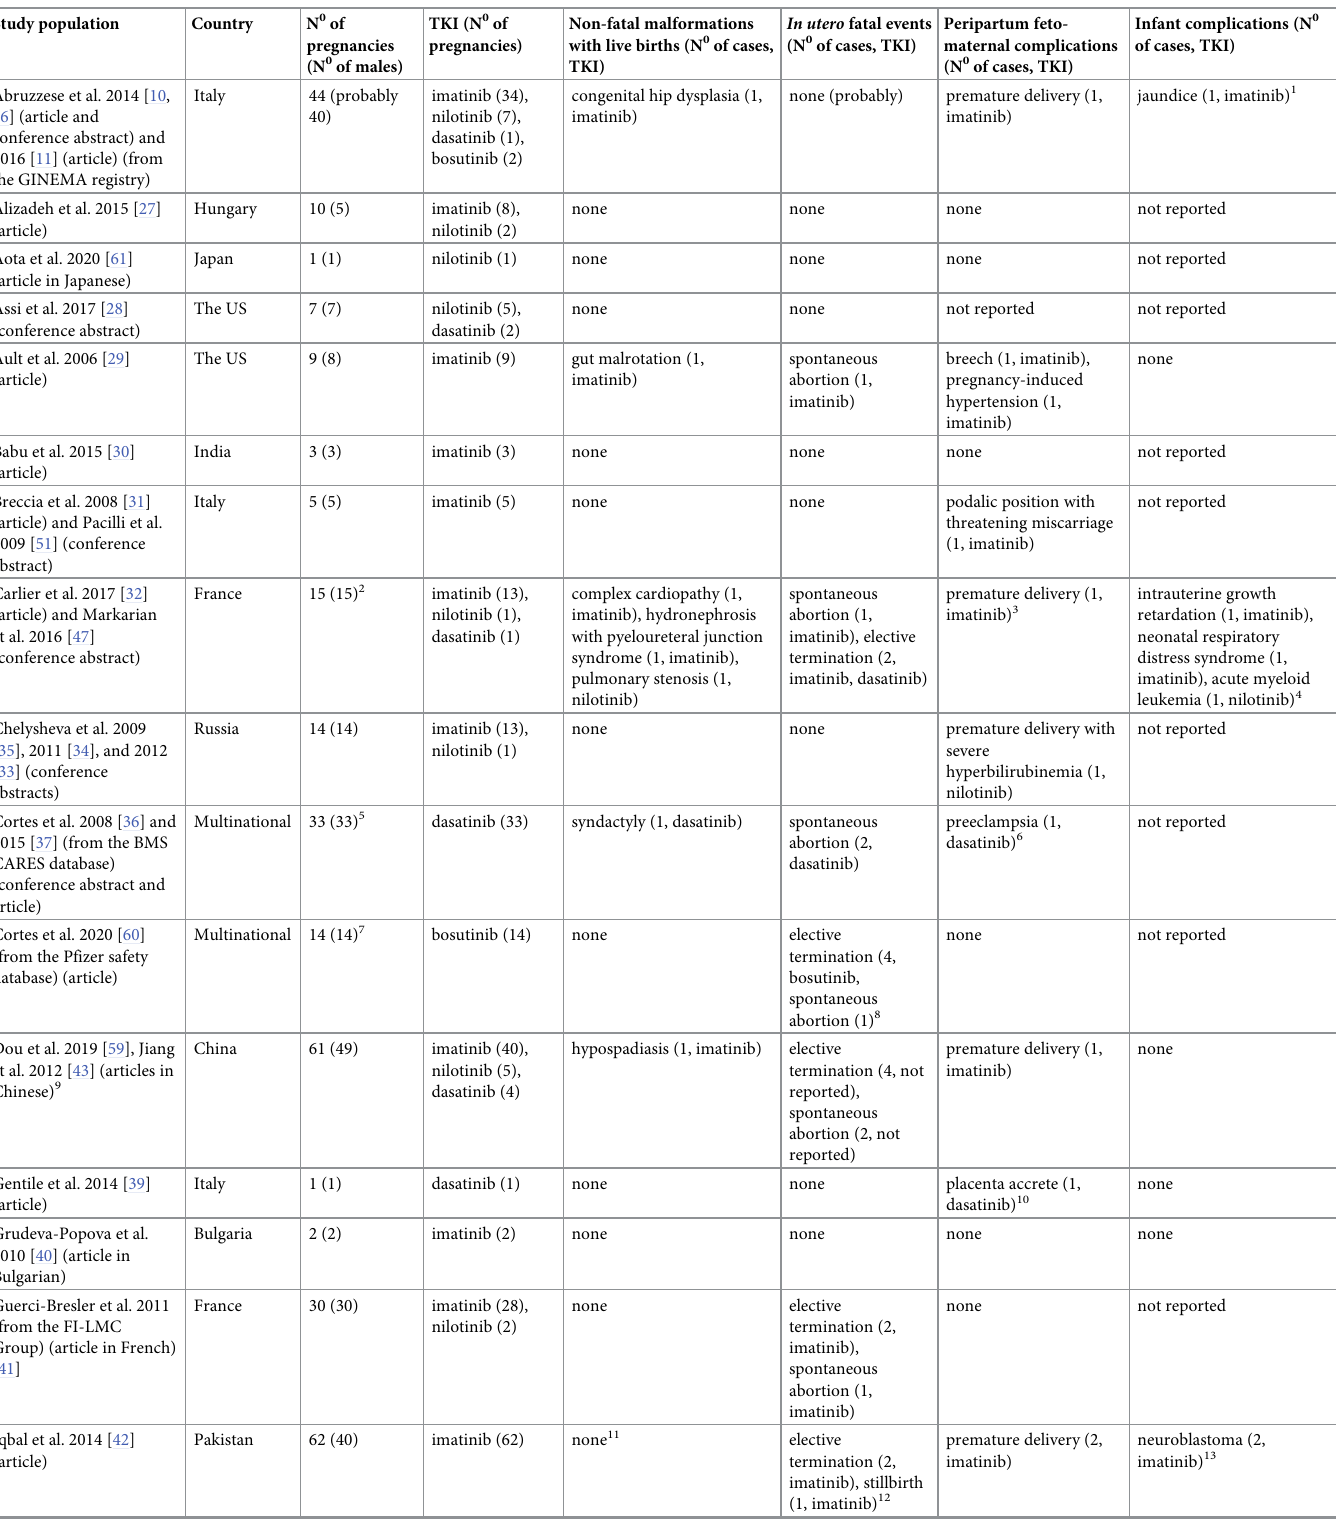
Table 2. Characteristics of the studies reporting on male patients not discontinuing tyrosine kinase treatment before conception. Study